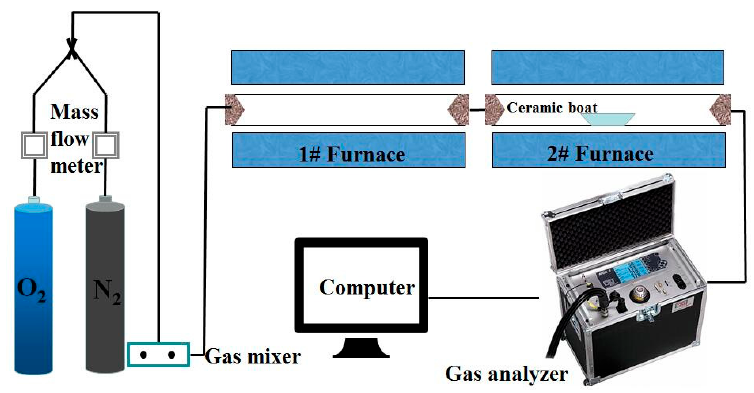
Figure 1. Double furnaces reactor.